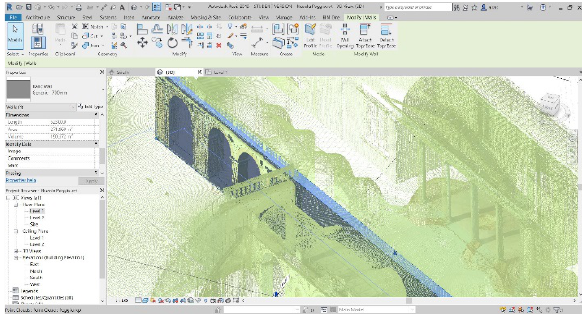
Figure 3: wall inserted in Revit Regular elements – slabs, stairs, orthogonal walls can be easy